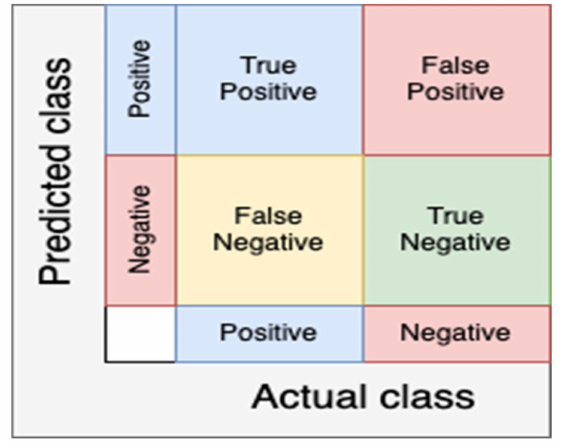
Figure 10. Confusion